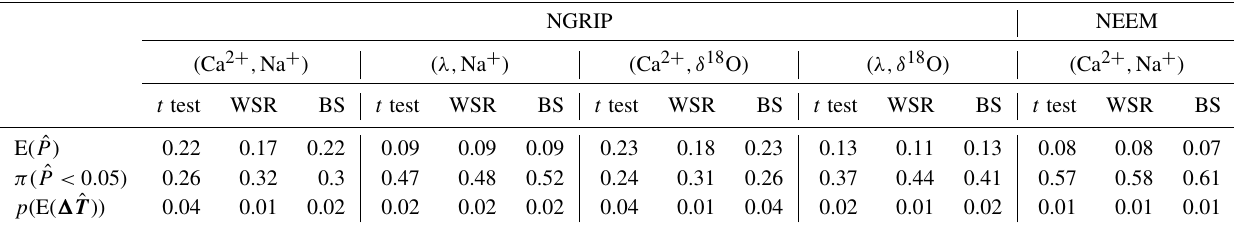
Table 1. Results from the application of the t test, the WSR test, and a bootstrap test to uncertain samples of DO transition onset lags (cid:49) ˆ T p,q . E( ˆ P ) denotes the expected p value, derived from the uncertainty-propagated p -value distribution. The probability of significant test results associated with the same distribution is indicated by π ( ˆ P < 0 . 05). For comparison, the p values from the application of the tests to the expected sample E( (cid:49) ˆ T ) = (cid:82) ρ ( (cid:49) ˆ t ) (cid:49) ˆ t d (cid:49) ˆ t are given in the bottom row. (cid:49) ˆ T